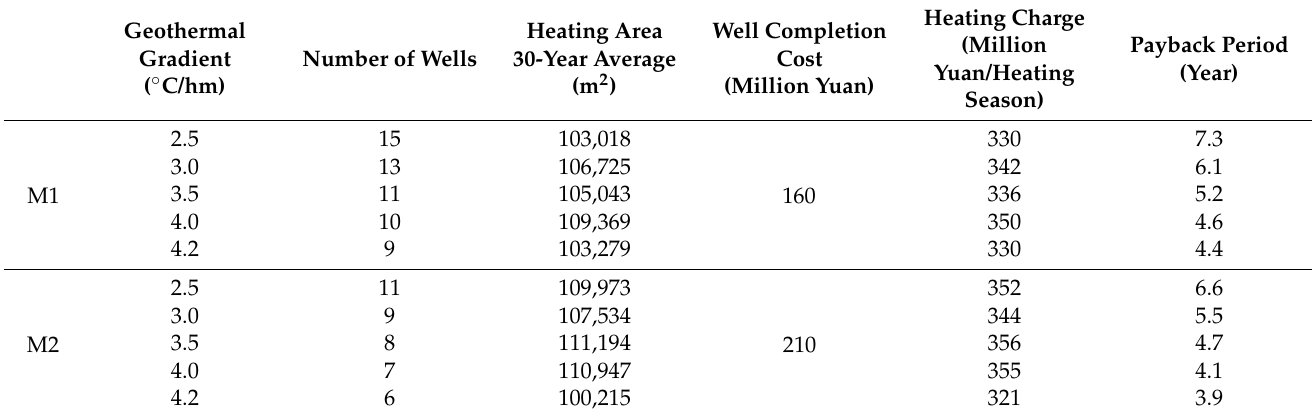
Table 5. Design of development schemes under different geothermal